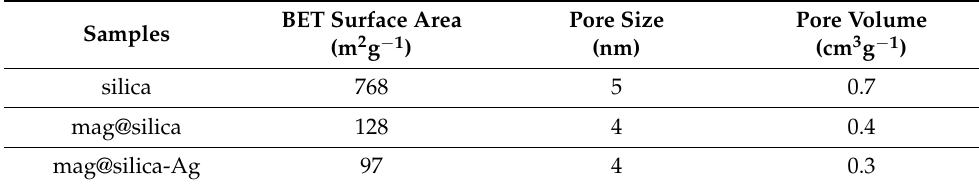
Table 2. Physical properties of the silica, mag@silica, and mag@silica-Ag.